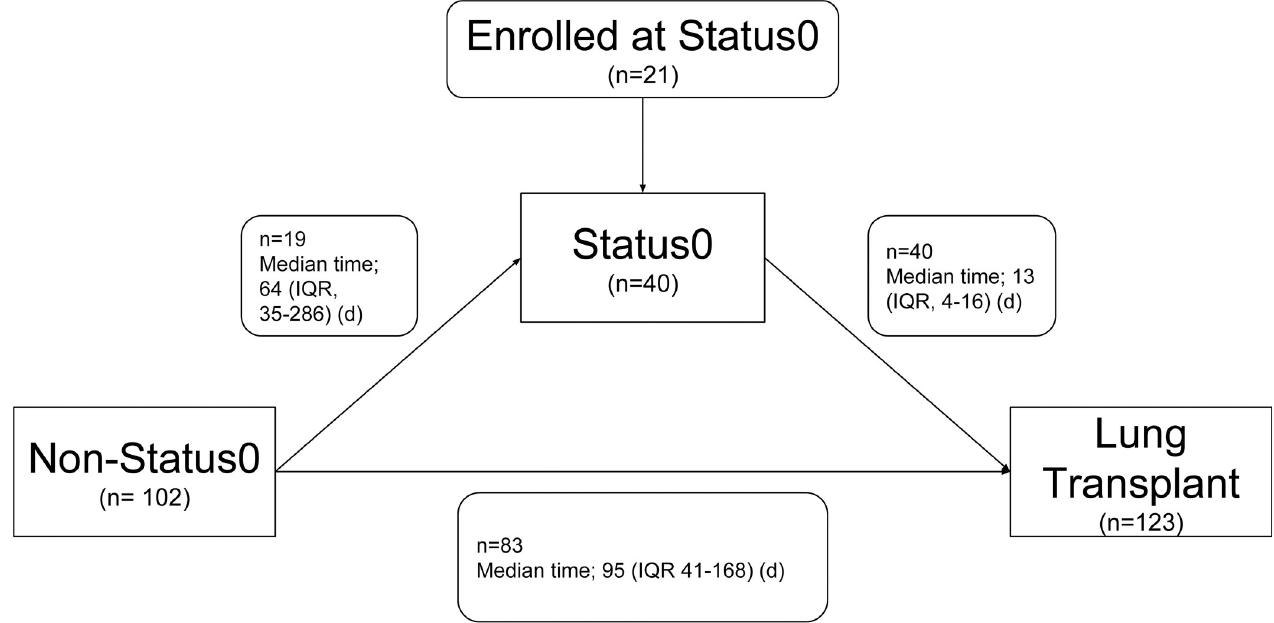
Fig 1. Changes in Korean urgency status during the waiting period. Abbreviation: IQR, interquartile range.